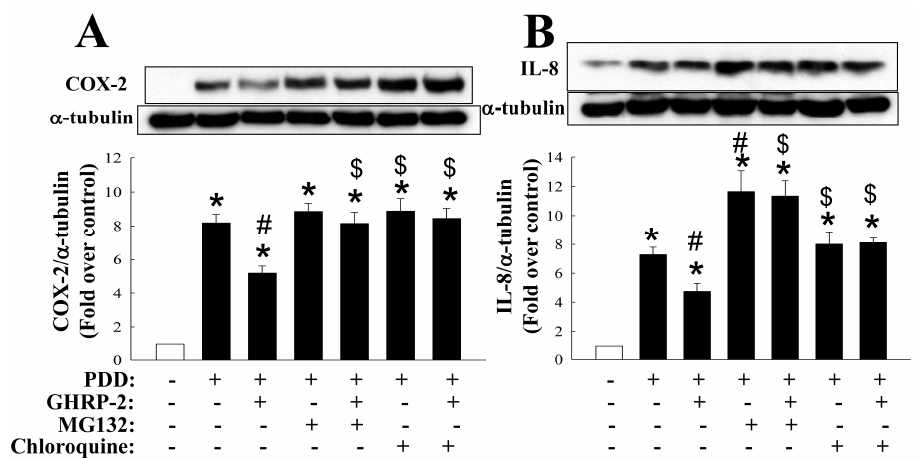
Figure 4. Involvement of the proteasome and lysosome pathways in the GHRP-2-enhanced degradation of COX-2 and IL-8 proteins. Plated KGN cells were pretreated with either the proteasome inhibitor MG132 (1 µM) or the lysosome inhibitor chloroquine (50 µM) in combination with GHRP-2 (1 µM) for 2 h, and then PDD (100 nM) was added for an additional 12 h. The intracellular COX-2 ( A ) and IL-8 ( B ) protein expression levels were determined by Western blotting assay. The results represent the means ± SEM ( n = 4) * p < 0.05 compared with the control; # p < 0.05 compared with the PDD treatment; $ p < 0.05 compared with the combined GHRP-2 and PDD treatment.